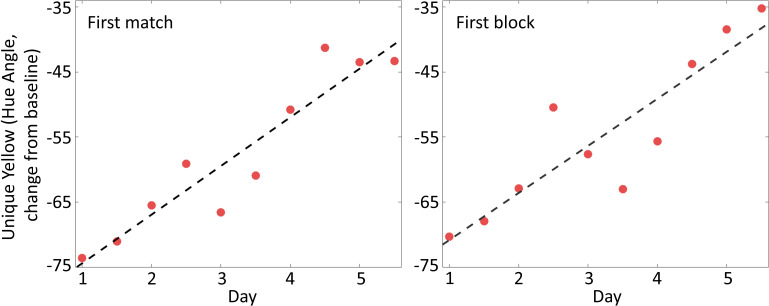
Rapid adjustment effects based upon the first match and the first block.Red dots in the left scatter plot show rapid adjustment computed as the first match with the glasses on in each session. The black dashed line is the least-square fit; the rapid effects shifted significantly across days (p < 0.01). The red dots in the right scatter plot show rapid adjustment computed as the average of the first 1 min block of each session with the glasses on. The black dashed line is the least-square fit. The rapid effects shifted significantly across days (p < 0.001).